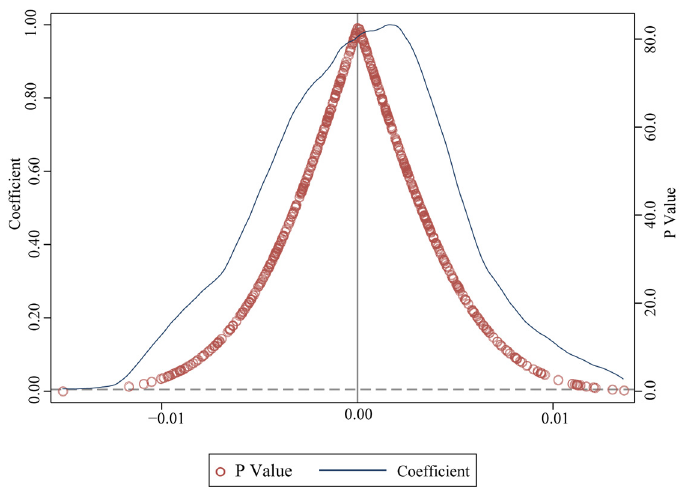
Figure 7. Kernel density of placebo test.